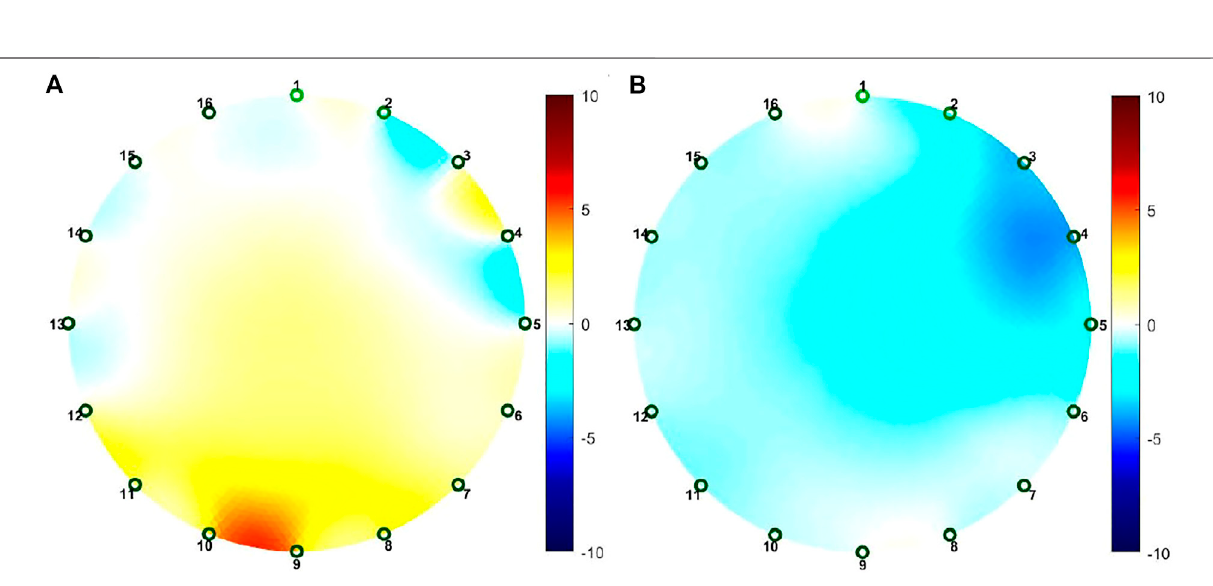
Frontiers in Electronics |